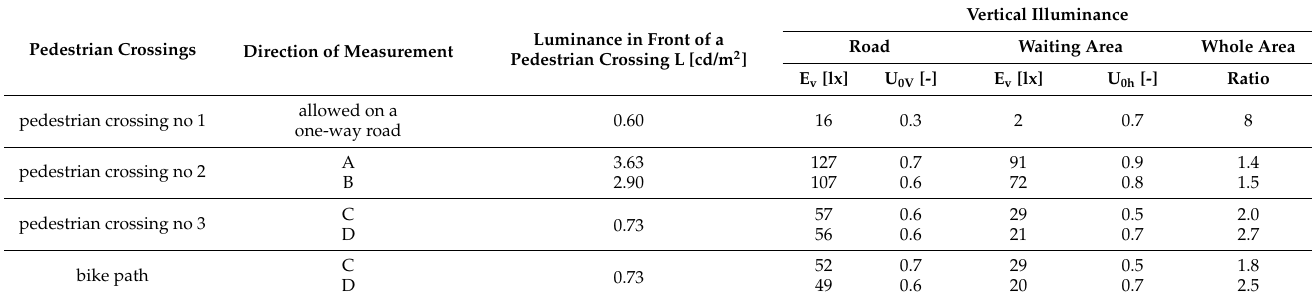
Table 4. Summary of calculation results for the tested pedestrian in line with the Czech